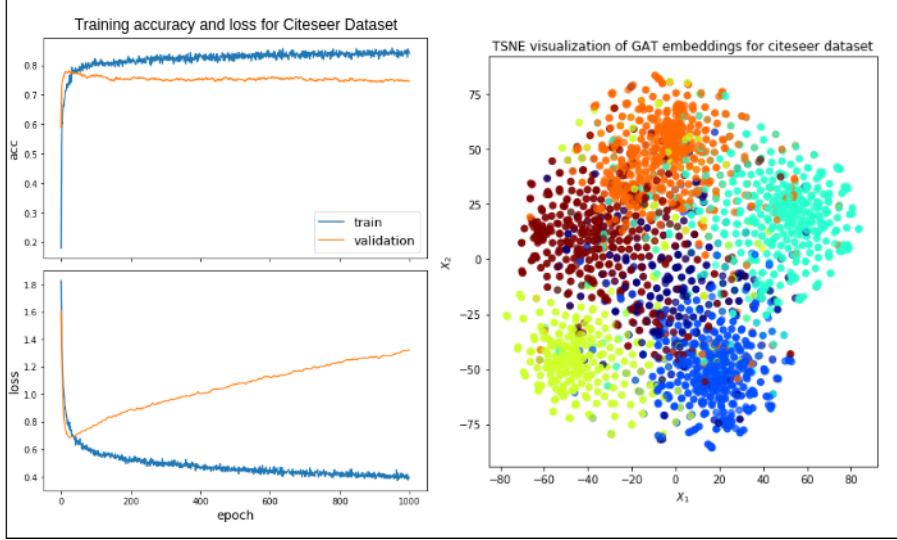
Figure 8. Graphical representation for Citeseer